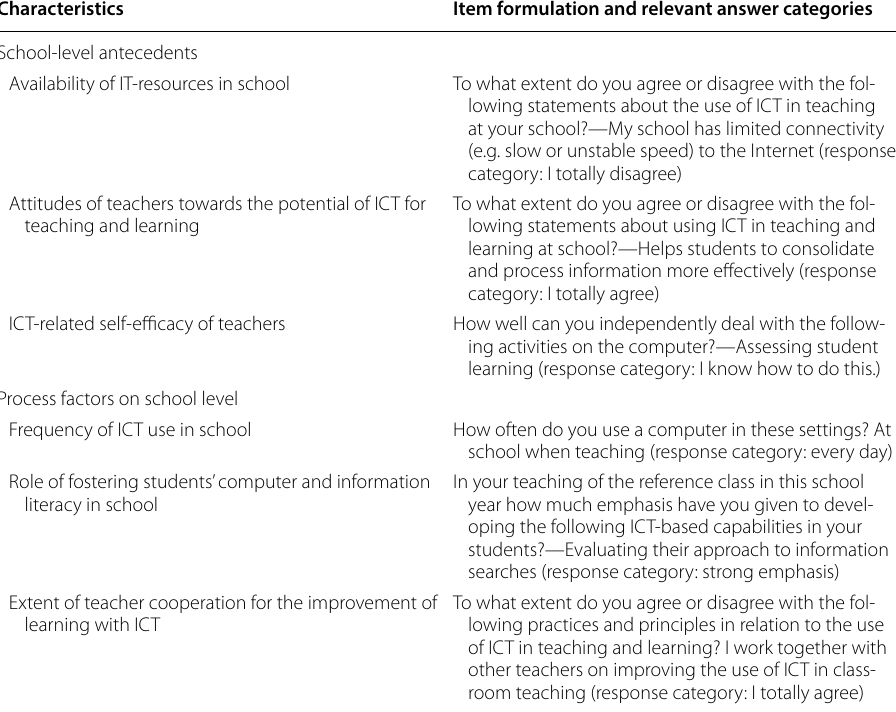
Table 2 School‑specific characteristics used to evaluate a typology of resilient schools